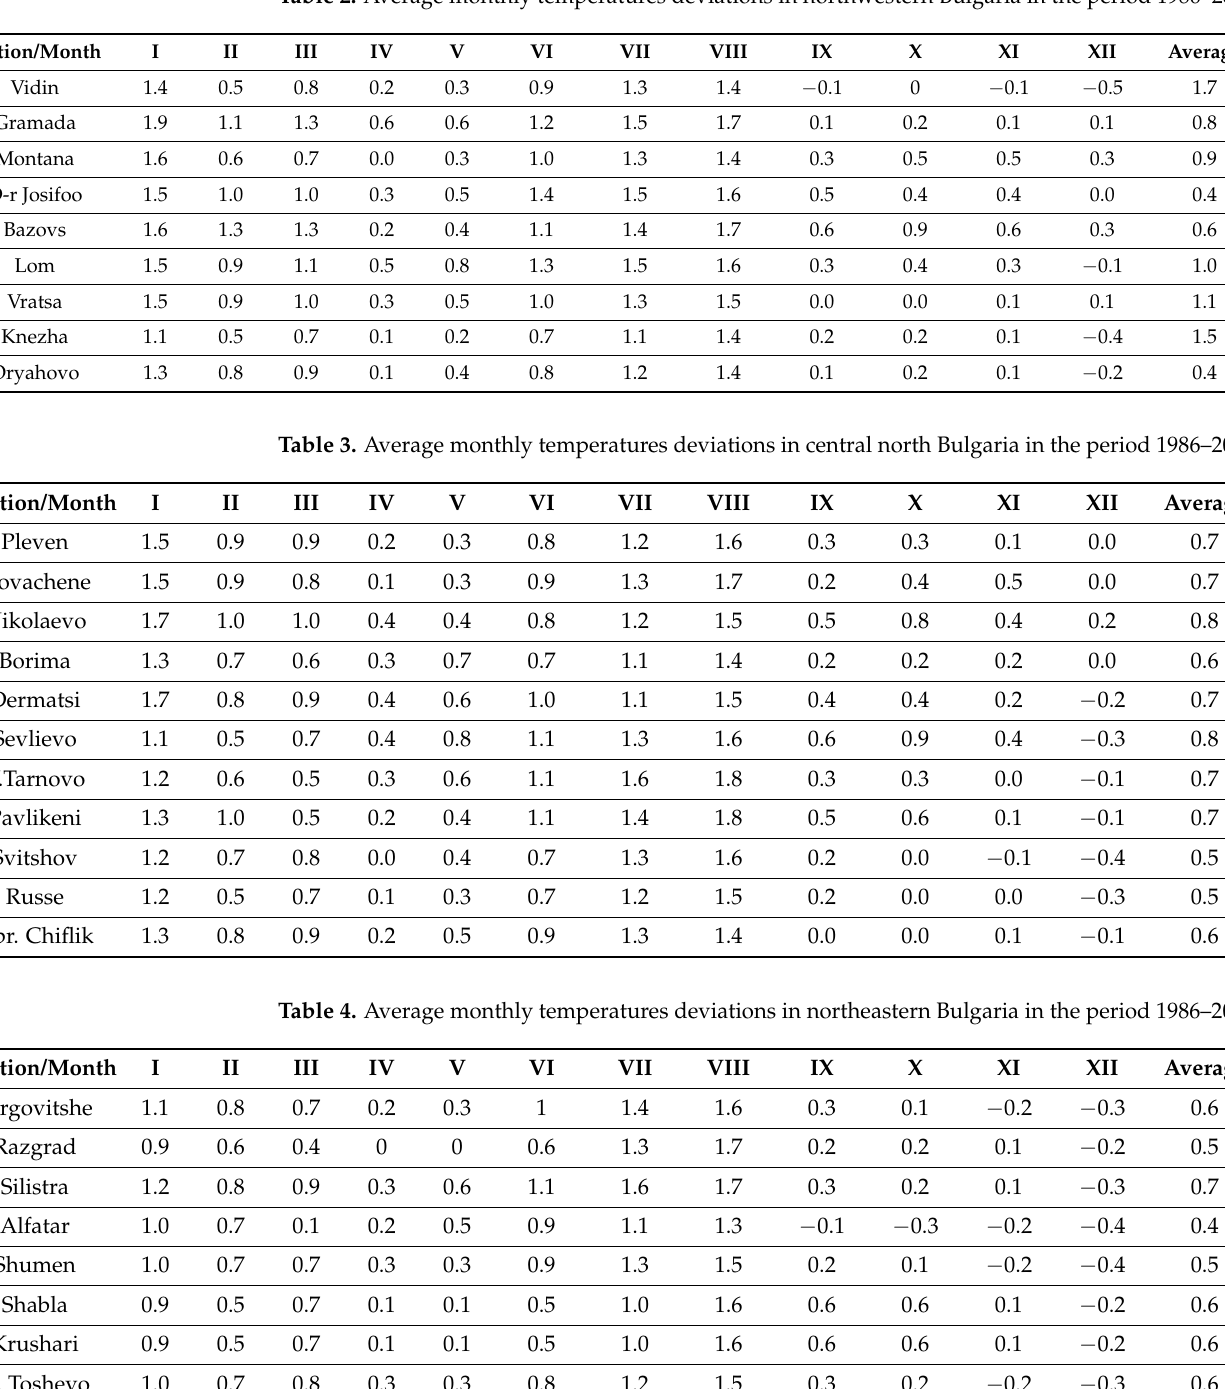
Table 2. Average monthly temperatures deviations in northwestern Bulgaria in the period 1986–2015.